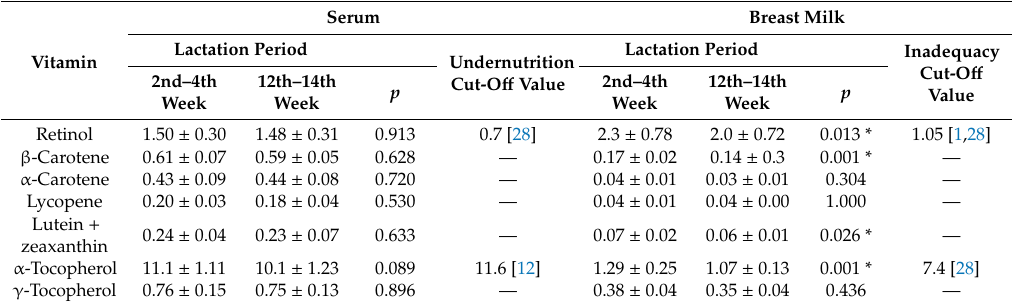
Table 3. Concentrations of fat-soluble vitamins ( µ mol / L) in the serum and breast milk of adult Brazilian nursing women ( n = 19), in early- (2nd to 4th week) and mid- (12th to 14th week) lactation, and respective cut-o ff values for inadequacy 1